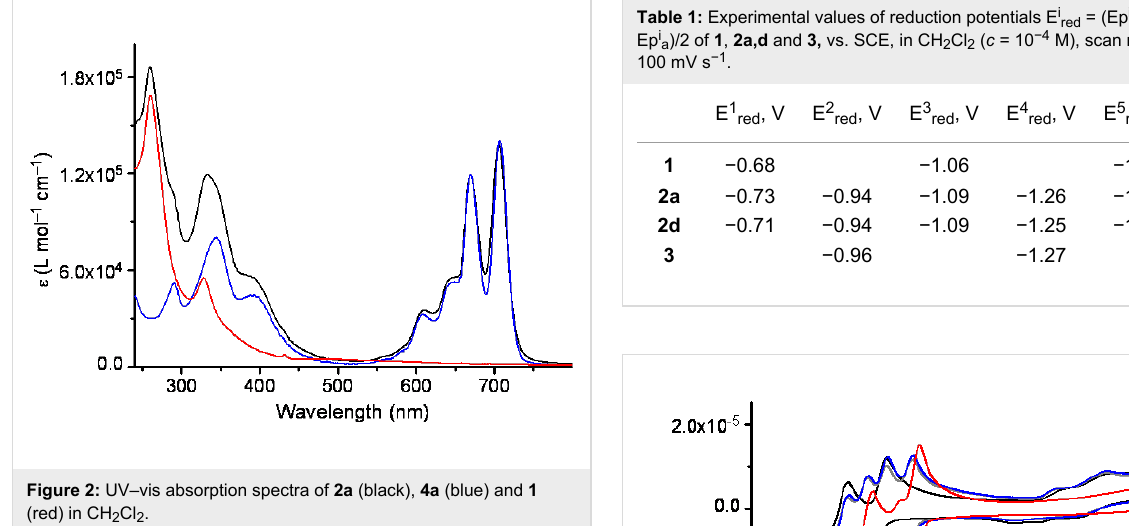
Cyclic voltammetry measurements of dyads 2a and 2d in